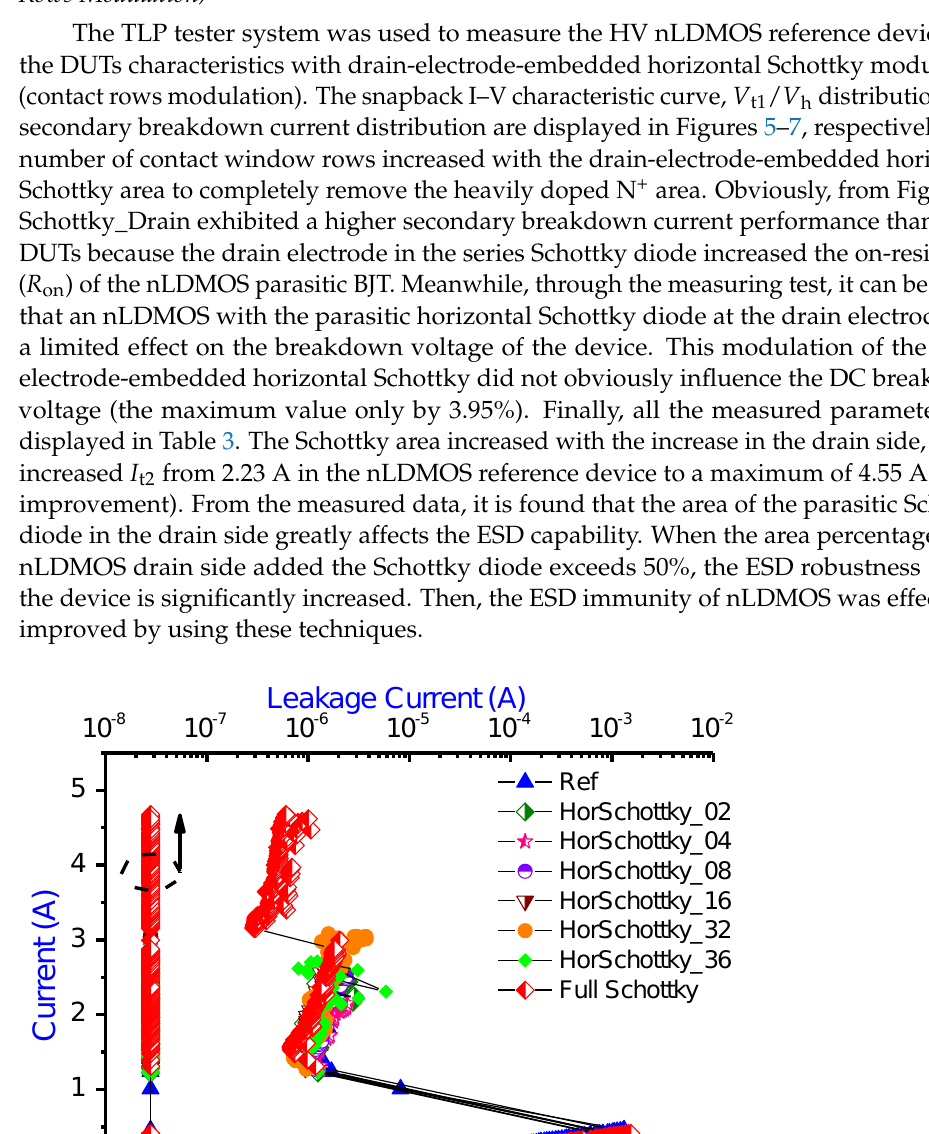
Figure 6. Trigger voltage and holding voltage distribution charts of HV nLDMOSs with the drain electrode-embedded horizontal Schottky rows modulation.